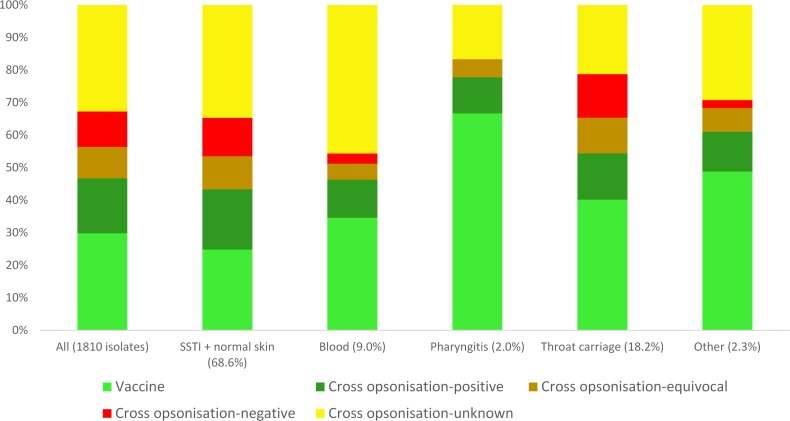
Distribution of isolates from different anatomical sites amongst vaccine protection classes.